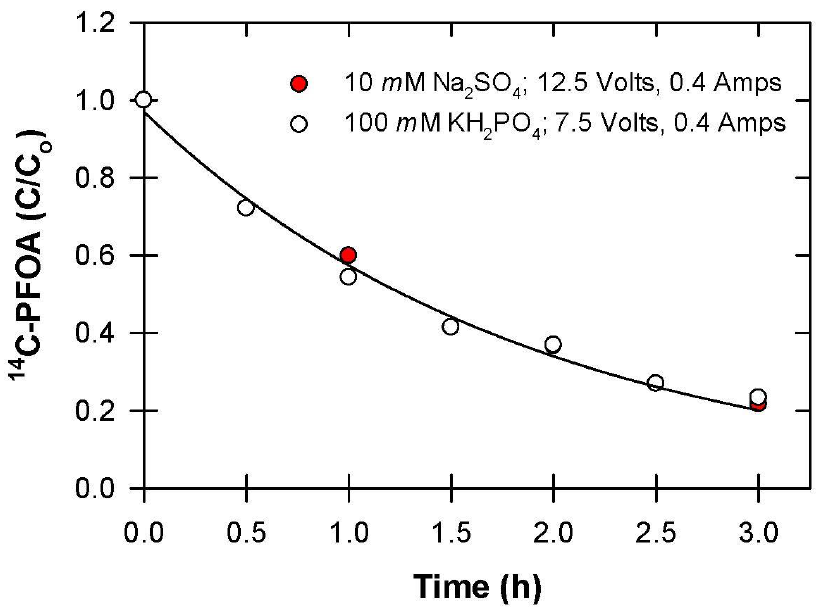
Figure 4. Effect of ionic salt and concentration on PFOA degradation by BDD treatment.